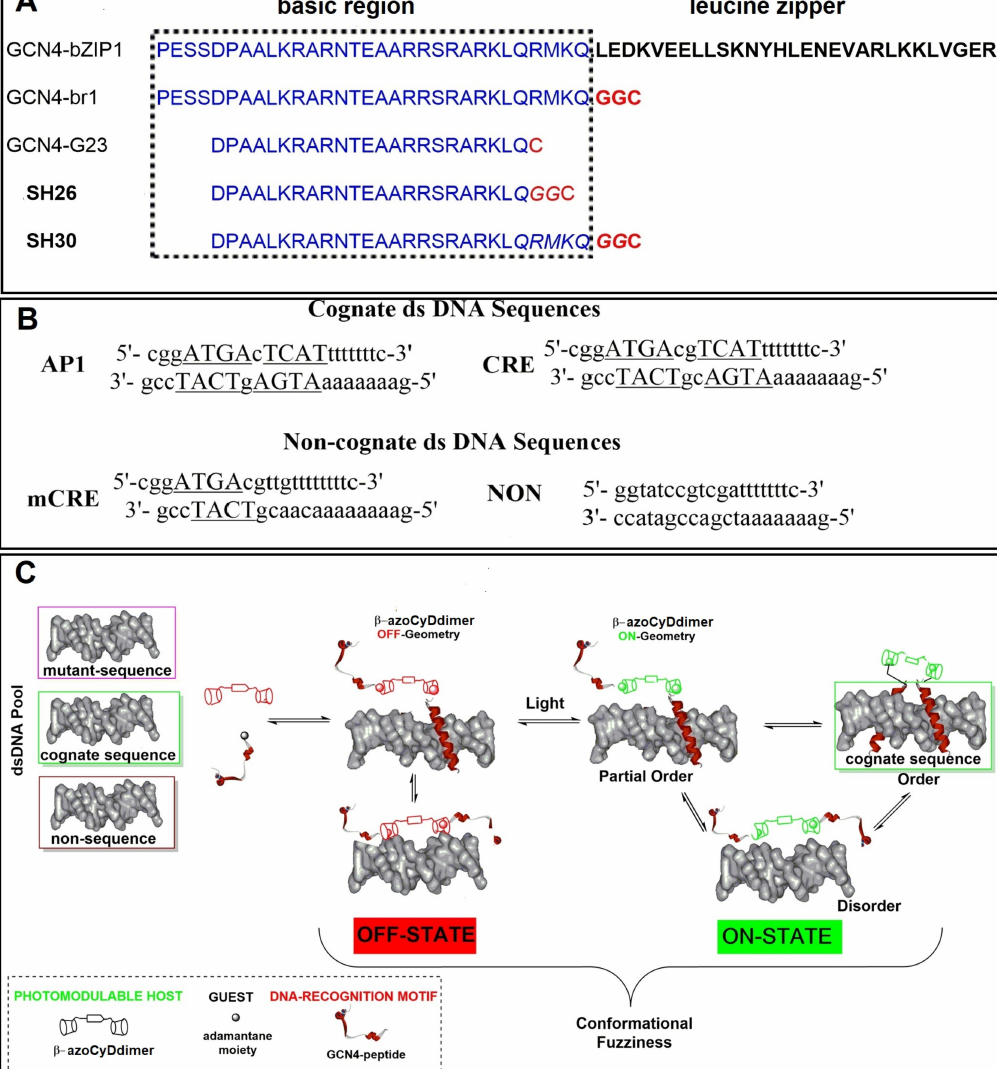
Figure 1. ( A ) Natural GCN4 sequence (GCN4-bzip), and di ff erent truncated GCN4 basic regions: GCN4-br1 [8], GCN4-G23 [9], SH26 [11], and SH30. ( B ) Cognate and